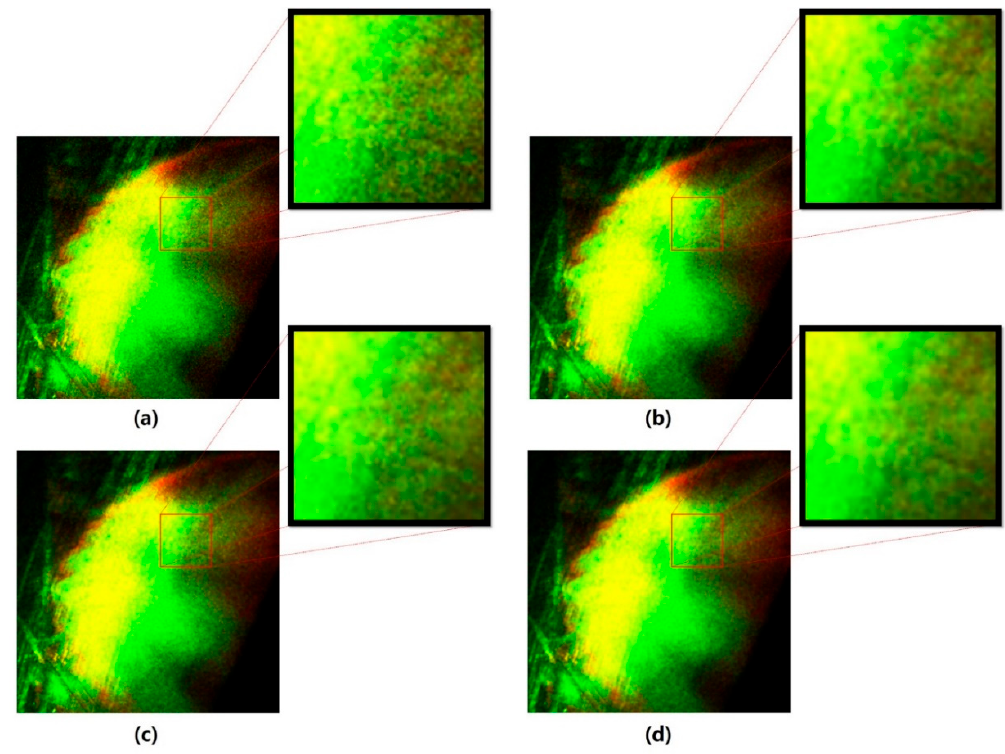
Figure 3. Tooth specimen obtained using CLSM, including the magnified region: ( a ) noisy image, ( b ) conventional median filter, ( c ) conventional Wiener filter, and ( d ) proposed total variation (TV) noise reduction algorithm.